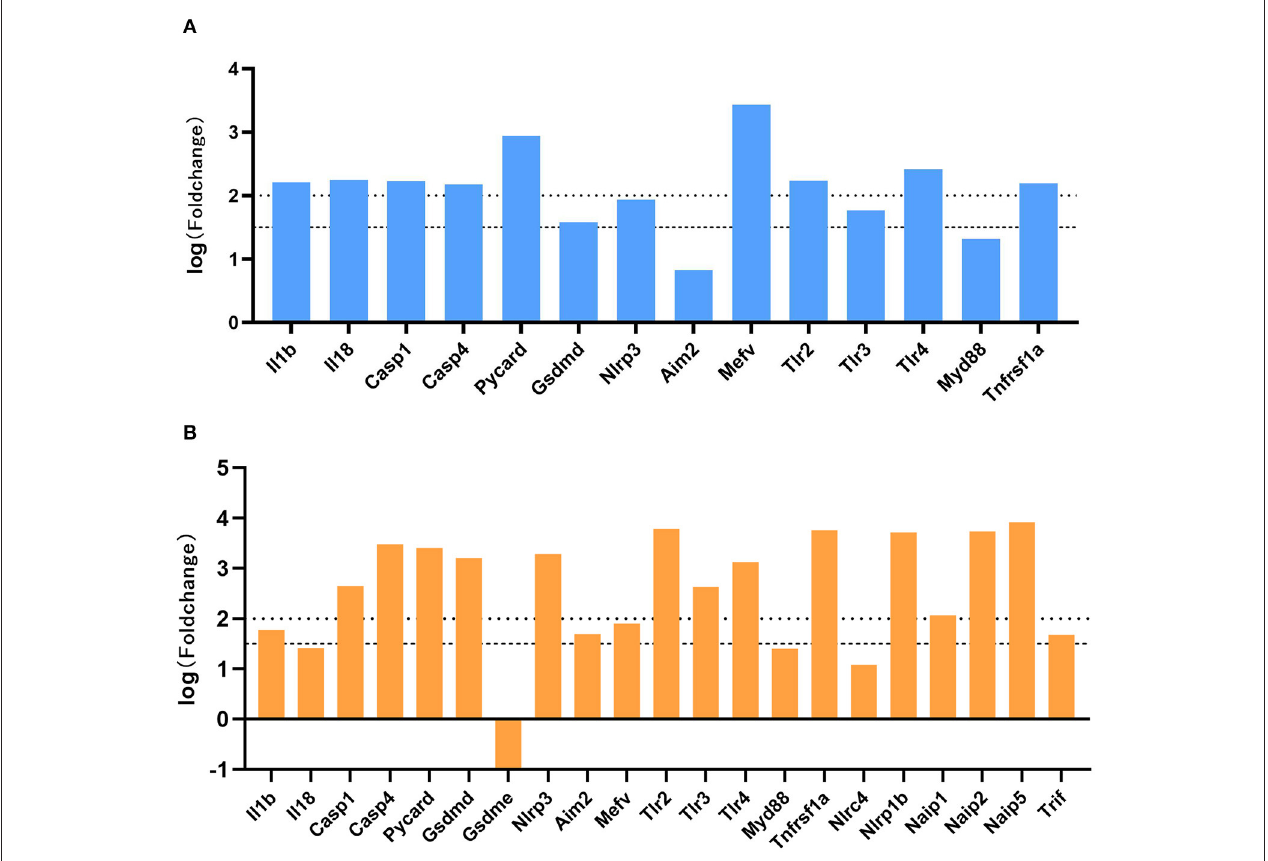
FIGURE 5 | Expression profiles of genes associated with pyroptosis-related molecules. (A) The log (fold change) of pyroptosis-related molecules in E-MTAB-1567 is shown. (B) The log (fold change) of pyroptosis-related molecules in GSE99577. Fold changes were calculated with respect to the expression of the sham group. A |log (fold change) | > 1.5 were considered statistically